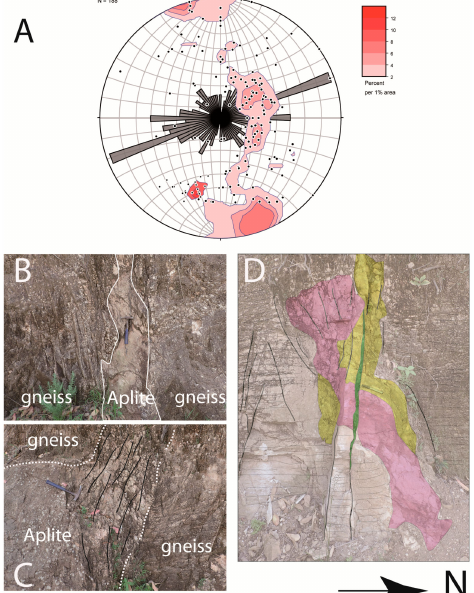
Figure 7. ( A ) Stereograms and rose diagrams of the REE bearing veins from the Gashirwe prospect (Low. Hem., Equal Area); ( B ) Aplite intruding gneiss, note the clustering of the post-aplite vertical dry jointing around the intrusive aplite dykes. Those dry fractures are almost parallel to the REE veins at the outcrop scale; ( C ) Similar pattern of “dry” fracturing within aplite which can enlarge as sill (bottom left). The gneiss foliation is disturbed by drag folding along the aplite and fractures; ( D ) REE veins (green) crosscutting aplite (pink) and pegmatite (yellow). The REE vein is not continuous and has a variable